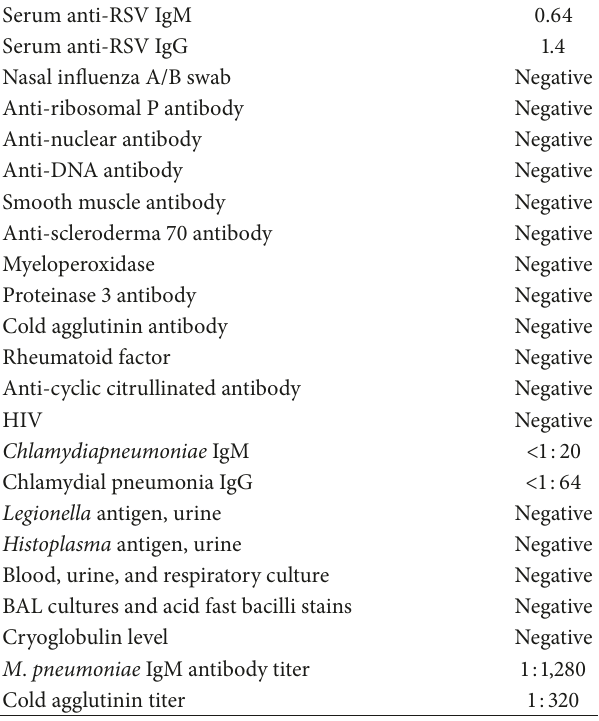
Table 1: Pertinent laboratory